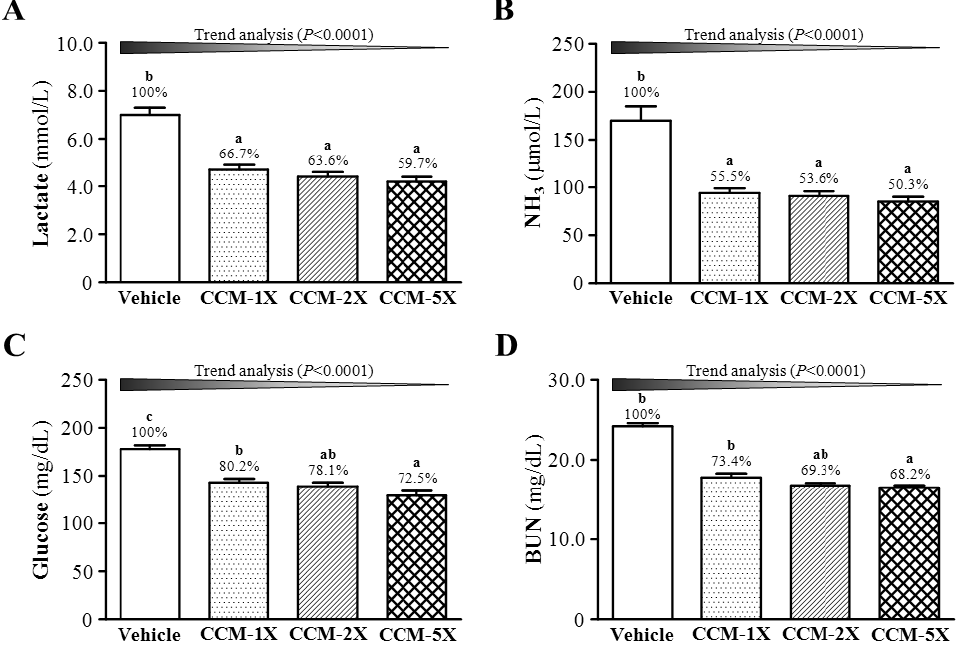
Figure 4. Effect of CCM supplementation on serum ( A ) lactate; ( B ) ammonia; ( C ) glucose; and ( D ) blood urea nitrogen (BUN) levels after acute exercise challenge. Data are mean ± SEM for n = 10 mice in each group. Different letters indicate significant difference at p < 0.05 by one-way